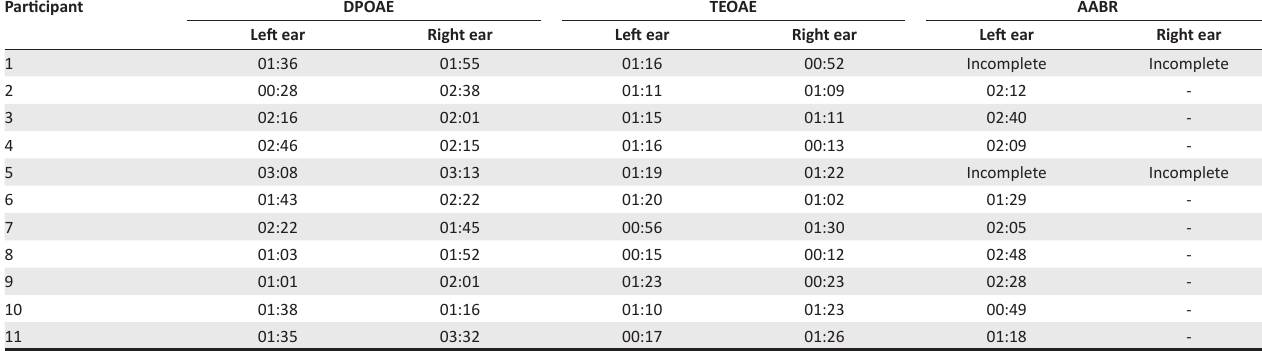
TABLE 3: Time taken to complete each of the screening measures at the initial screening in minutes and seconds. Participant